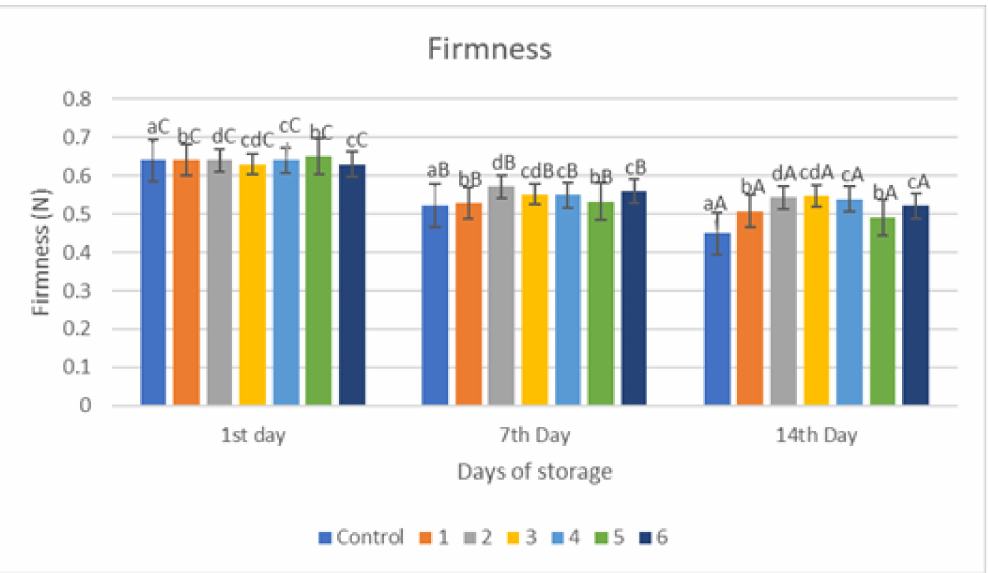
Figure 4. Firmness of red chili during storage. a–d non-capital letters show the difference between the sample ( p < 0.05). A–C capital letters show the difference between the day of storage ( p < 0.05). Control: Uncoated Sample; 1: Gelatin75%-Pectin25%-Garlic Essential Oil2%; 2: Gelatin75%-Pectin25%-Garlic Essential Oil Oil3%; 3: Gelatin50%-Pectin50%-Garlic Essential Oil Oil2%; 4: Gelatin50%-Pectin50%- Garlic Essential Oil Oil3%; 5: Gelatin25%-Pectin75%-Garlic Essential Oil Oil2%; 6: Gelatin25%- Pectin75%-Garlic Essential Oil